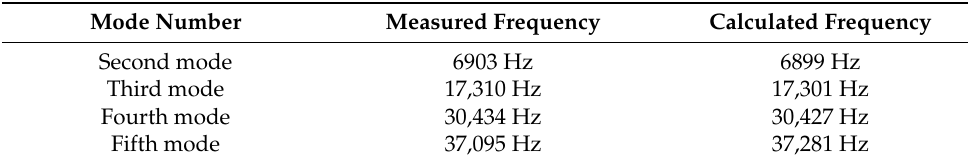
Table 5. Comparison of calculated and measured frequencies.